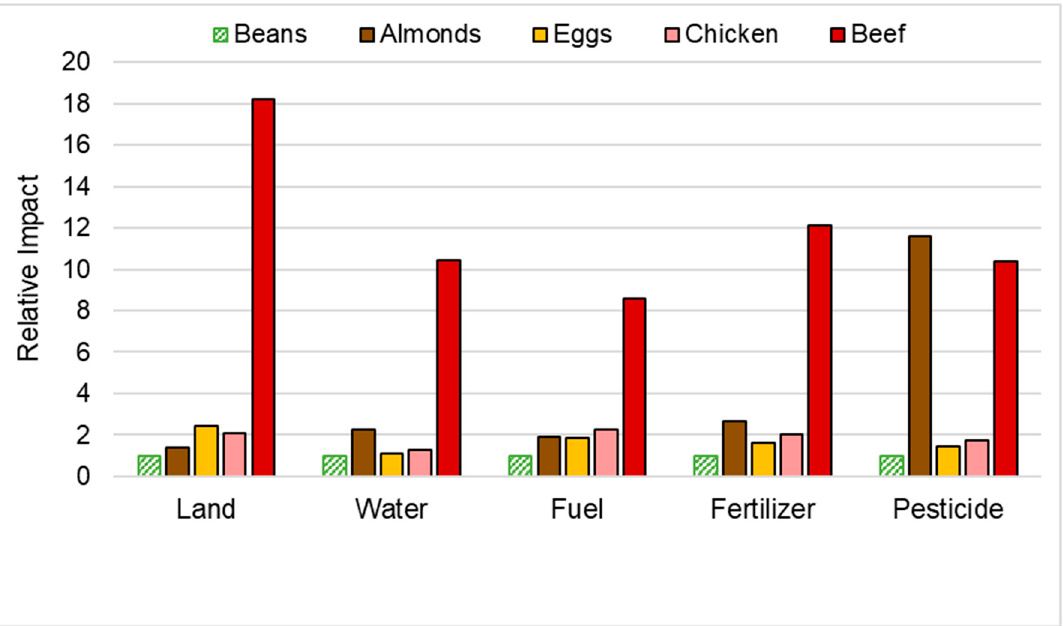
Figure 2. Relative Environmental Impacts of Protein Food Sources in relation to protein from beans [23].